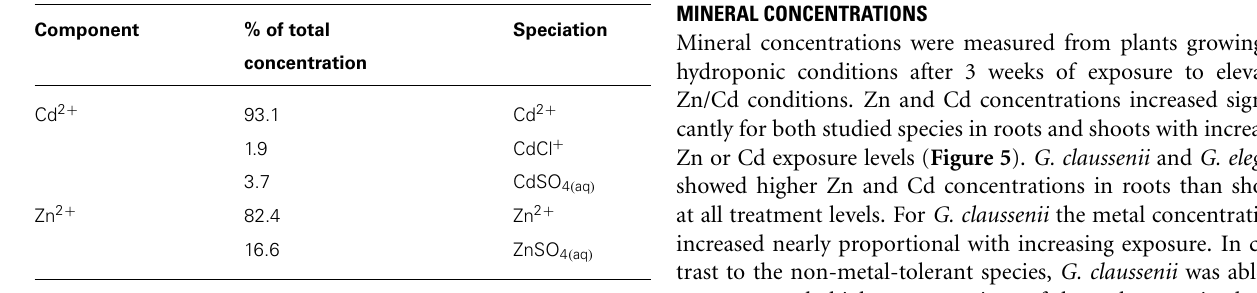
Table 2 | Zinc (Zn) and cadmium (Cd) speciation in half-strength Clark’s solution containing the highest Zn or Cd concentrations